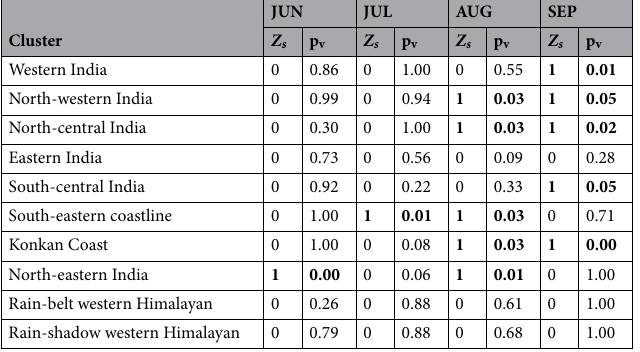
Table 4. Same as Table 3 but for